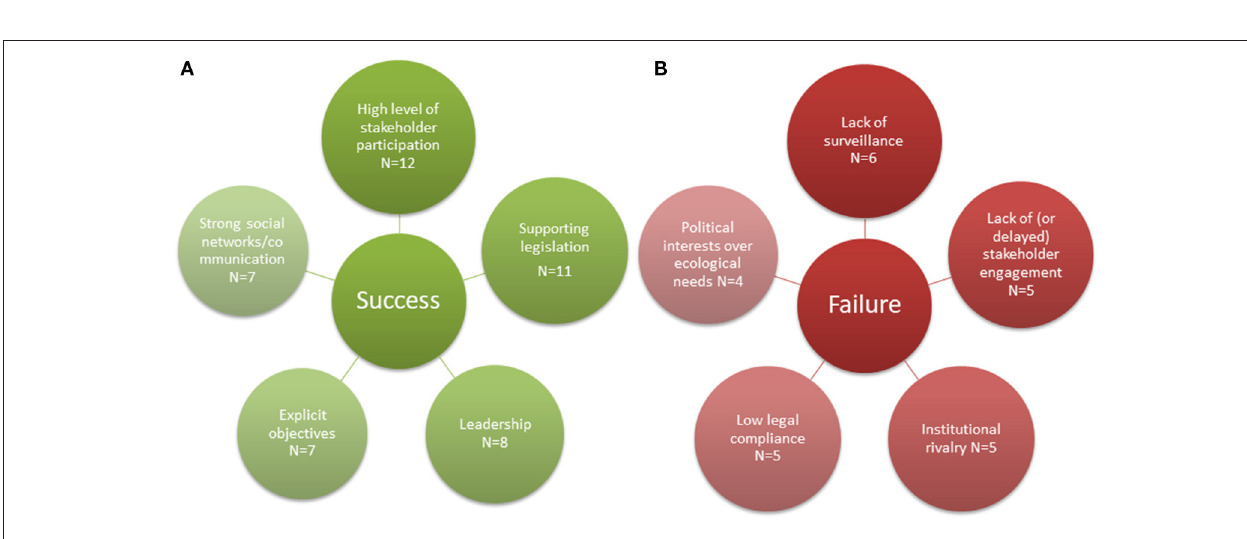
whereas some factors were identified as critical for success, their absence was not identified as a driver of failure (Table